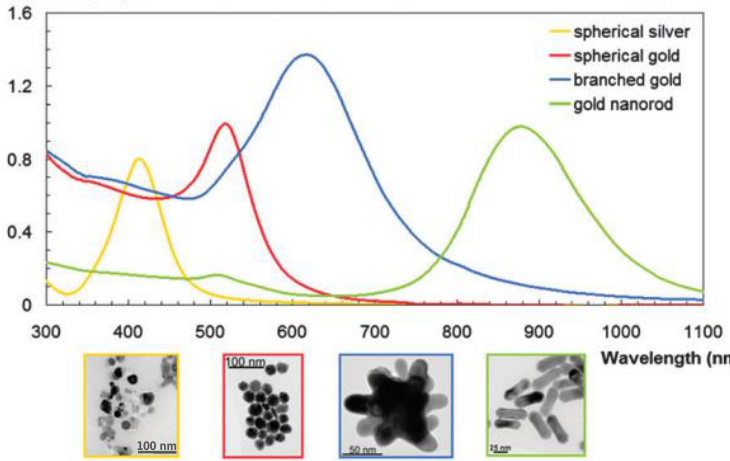
Figure 8. SPR feature of gold and/or silver NPs of different shapes. Reproduced from [111], with permission from RSC Publisher, 2012.